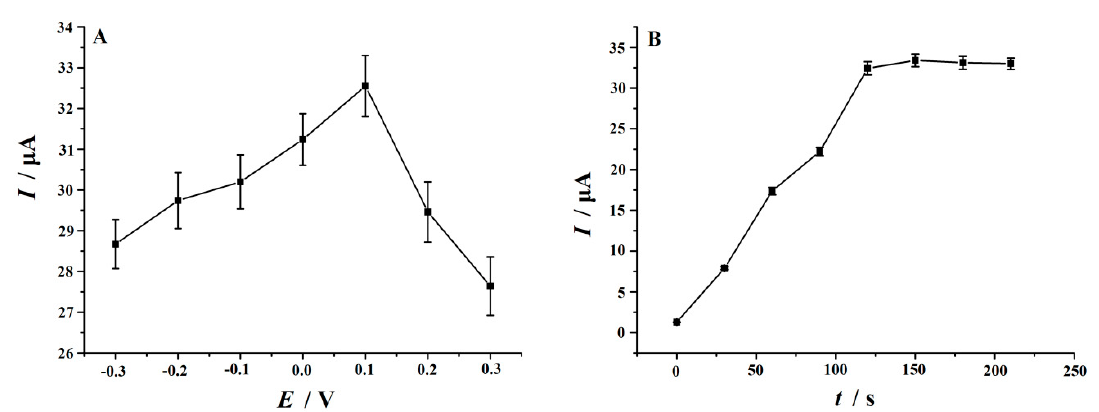
Figure 8. ( A ) The effect of accumulation potential ( A ) and accumulation time ( B ) on the peak current. Vanillin concentration: 10 µM, supporting electrolyte: 0.1 M HCl, scan rate: 0.1 V s − 1 .